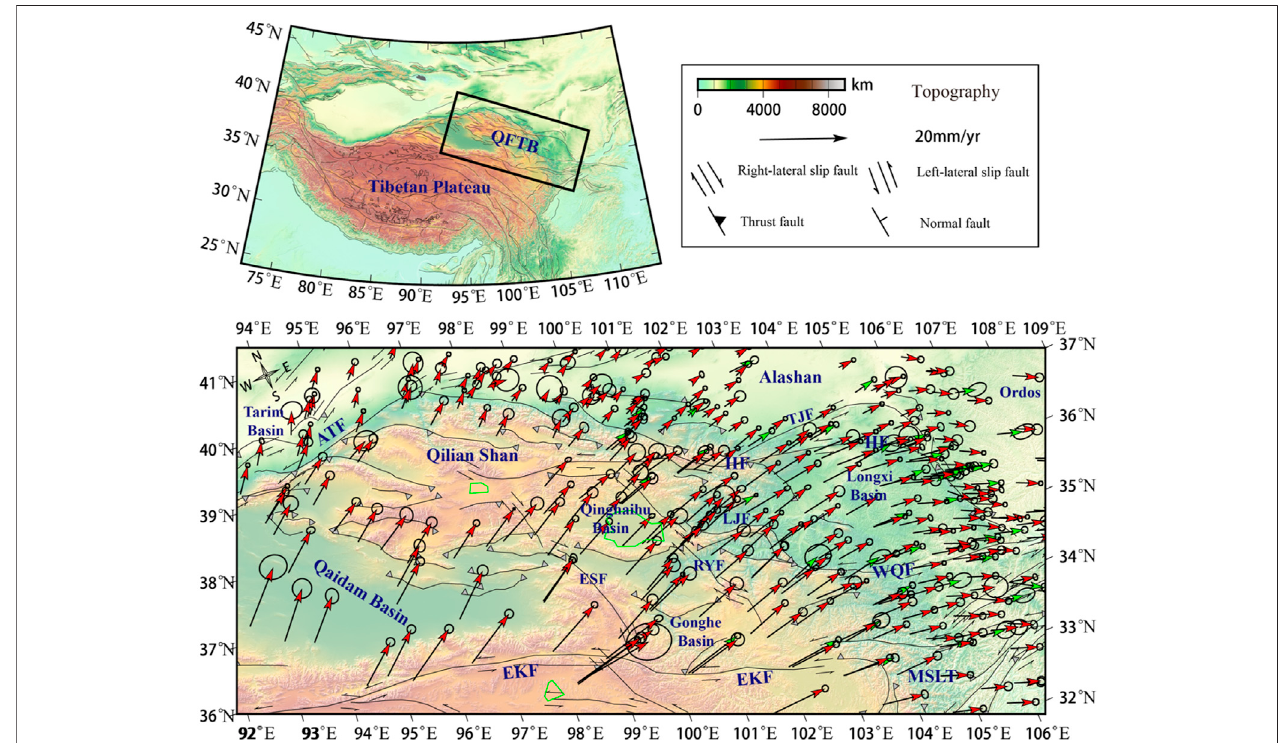
FIGURE 1 | Tectonic map of the Qilian fold-and-thrust belt (a) located in the India – Eurasia collisional belt (b) with the combined GPS velocity fi eld including uncertainties (95% con fi dence ellipses) relative to a Eurasian reference frame. Velocity with red arrows from Wang and Shen (2020) and velocity with green arrows from Suetal.,2018.TheblacksolidlinesrepresentfaultsfromStyronetal.(2010);ZuzaandYin(2016).Abbreviations(fromnorthtosouth):QFTB=Qilianfold-and-thrustbelt; ATF =Altyn Tagh fault; HF = Haiyuan fault; EKF = East Kunlunfault; TJF = Tianjingshan fault; RYF= Riyueshan fault; ESF =Elashan fault; WQF= West Qinling fault; LJF = Laji fault; MSLT = Min Shan – Longmen thrust belt.